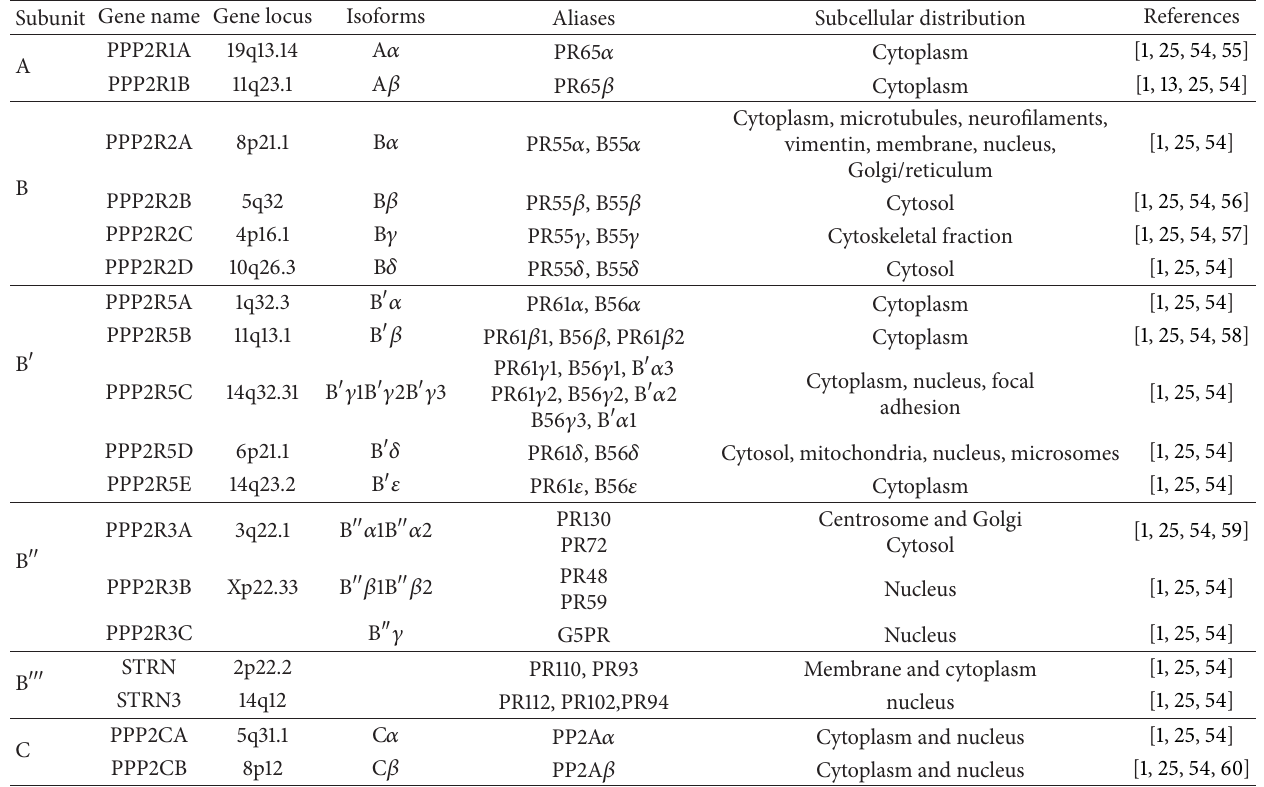
Table 1: Nomenclature of subunits of PP2A and the subcellular